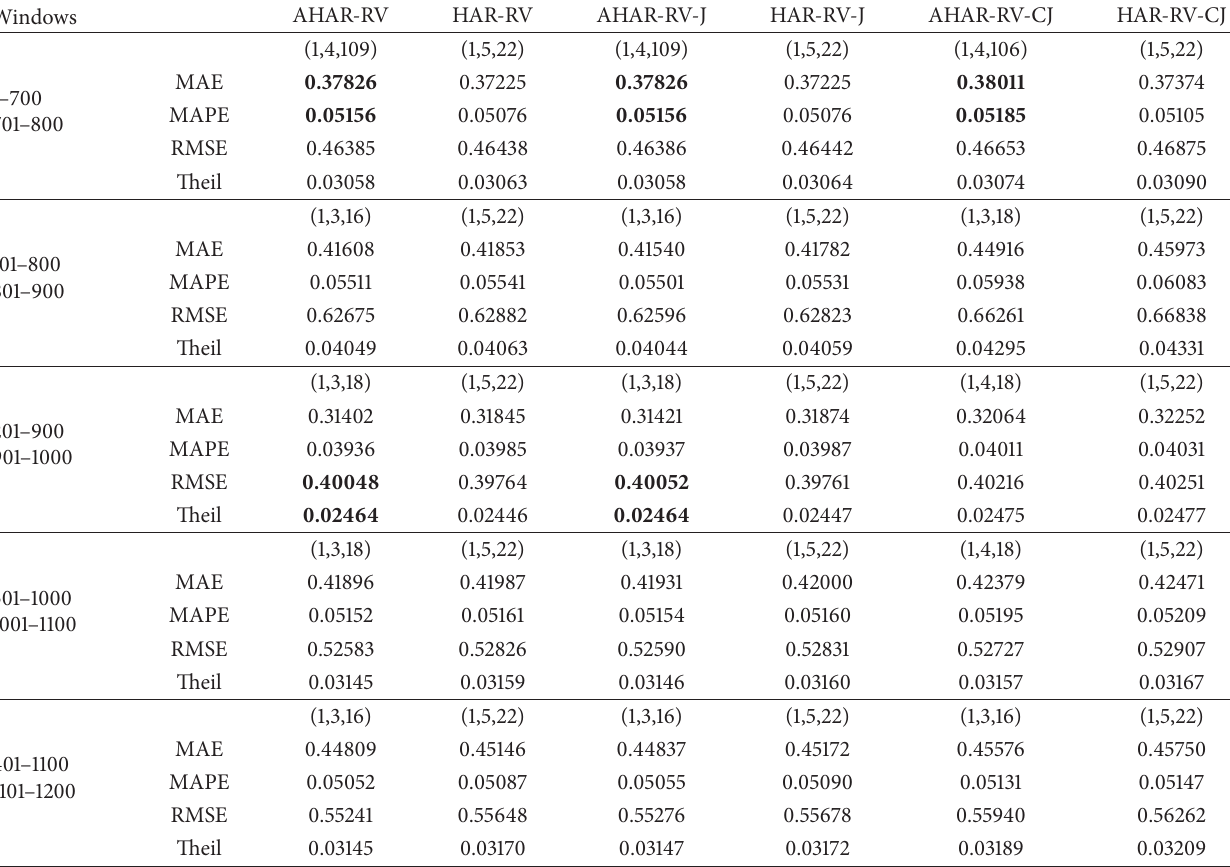
Table 3: Moving window out-of-sample forecast performance comparison